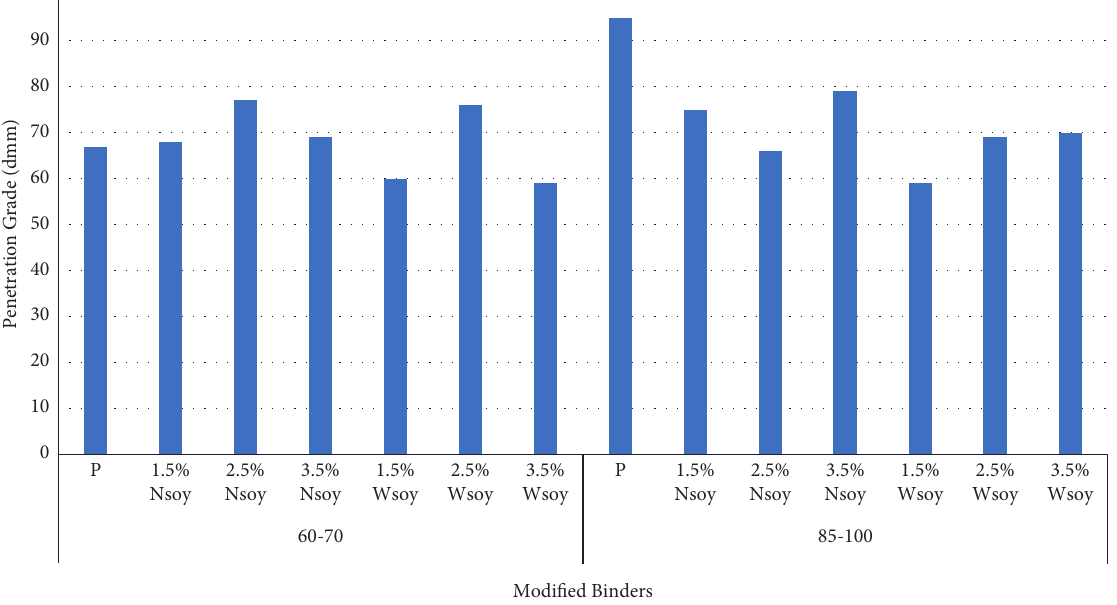
Figure 4: Penetration results of unmodified and modified asphalt mixtures.